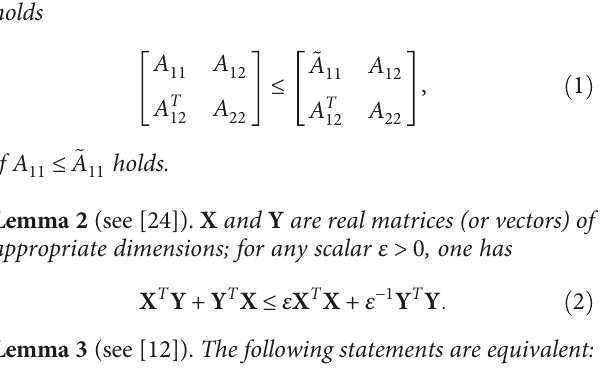
Body 1: fuselage Body 2, Body 4: fixed wings Body 3, Body 5: telescopic